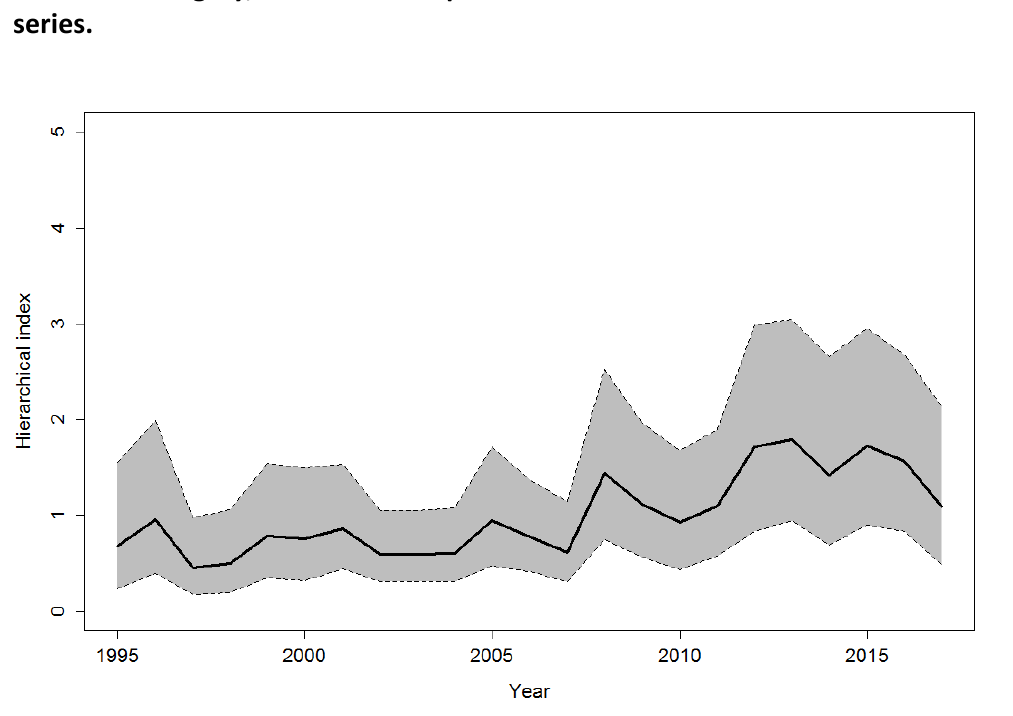
Figure 82. Time series of horseshoe crab relative abundance in the Southeast region as estimated from hierarchical analysis. The black line gives the posterior mean and the grey, shaded area represents a 95% credible interval about the time